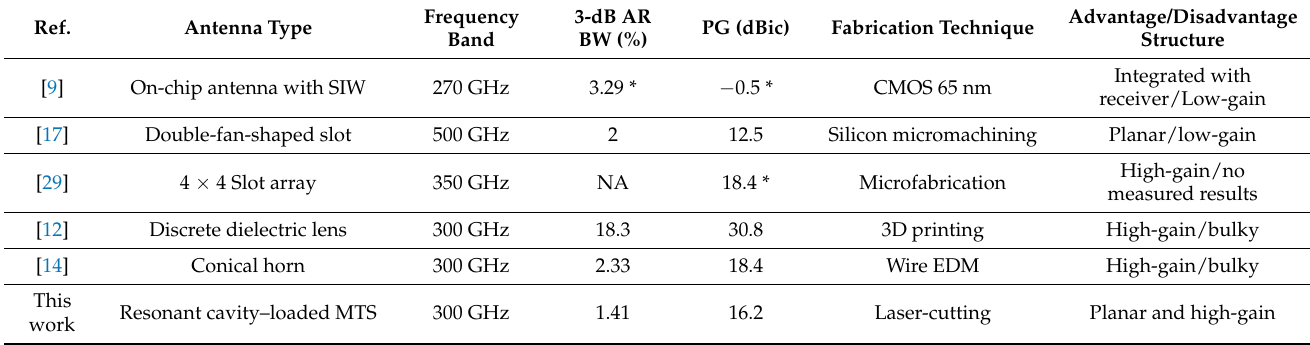
Table 2. Comparison between the proposed work with other latest CP sub-THz antenna.